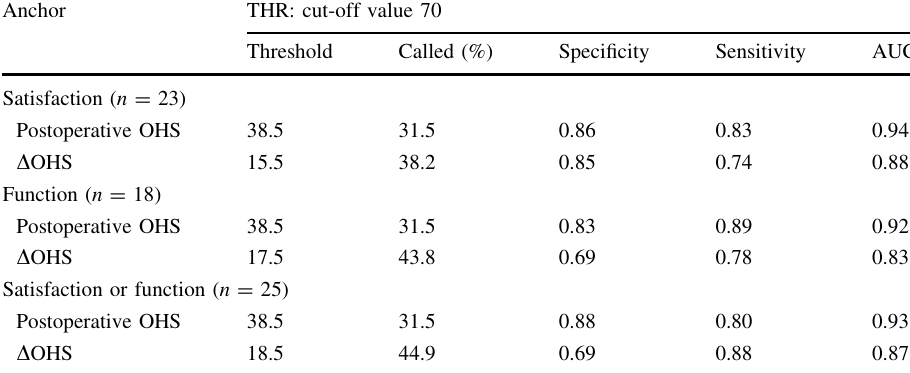
Table 3 Thresholds, percentage of patients who will be called with the given threshold, specificity, sensitivity and area under curve (AUC) for OHS and D OHS anchored to patient-perceived satisfaction, function and either satisfaction or function with a cut-off value of 70